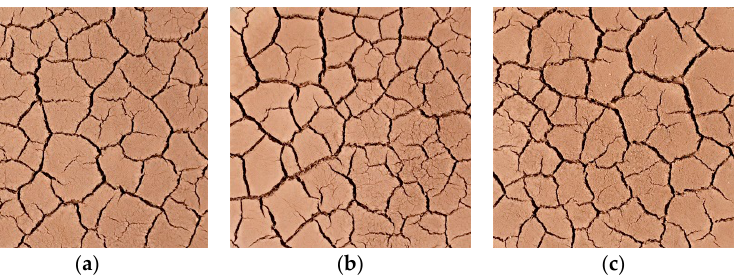
Figure 5. Fracture development morphology of soil sample in the second dry–wet cycle. ( a ) Group S1 specimens; ( b ) Group S2 specimens; ( c ) Group S3 specimens.